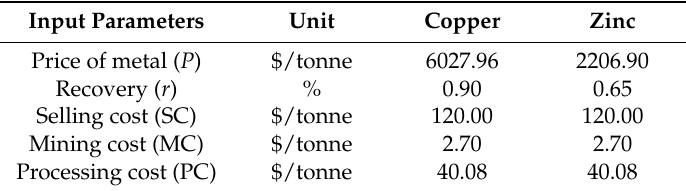
Table 3. As 100 copper RFs and 100 zinc RFs were estimated, the BEV calculation of the block model of the study area was also conducted 100 times. Table 3. Economic parameters for calculating blocks’ economic values.